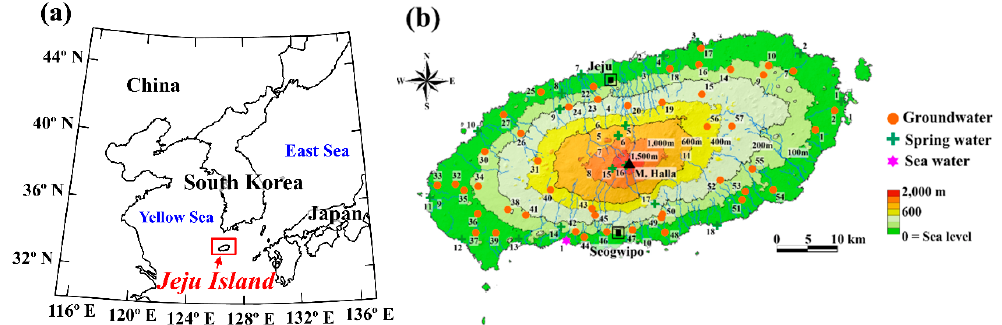
Figure 1. Location map of the study area (Jeju Island) in South Korea ( a ) and location map of groundwater, spring water and sea water samples collected in Jeju Island ( b ).